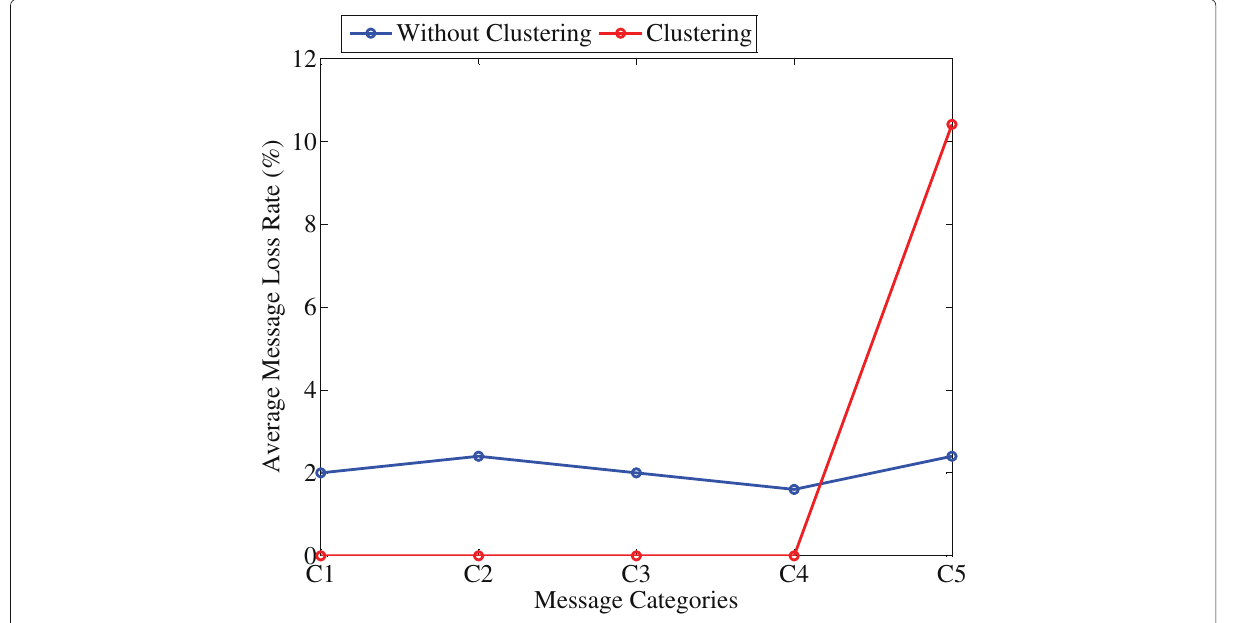
Fig. 5 The average message loss rate in different